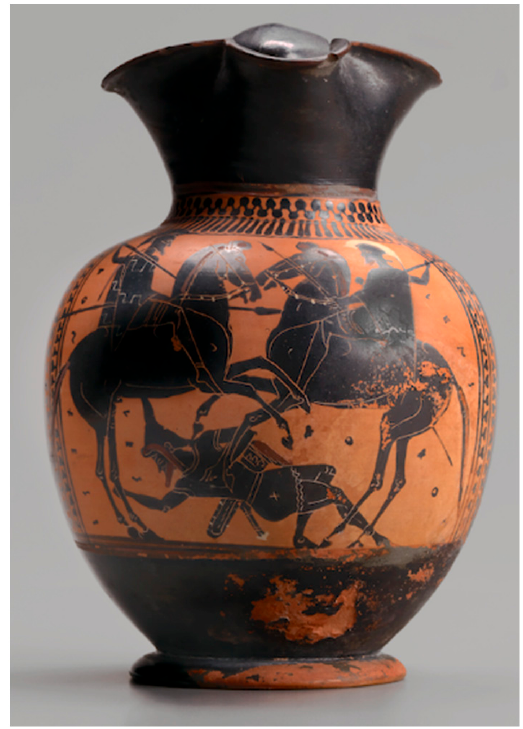
Figure 12. Trefoil oinochoe. Ca. 510 BCE. Tampa Museum of Art, Joseph Veach Noble Collection. Inv. no. 1986.041.